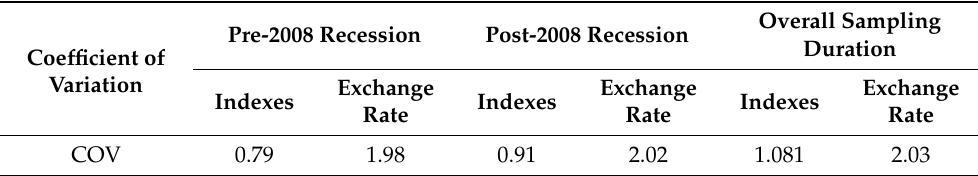
Table 2. Coefficient of variation across currency rate variations and ASEAN-5 stock indexes during multiple time frames.